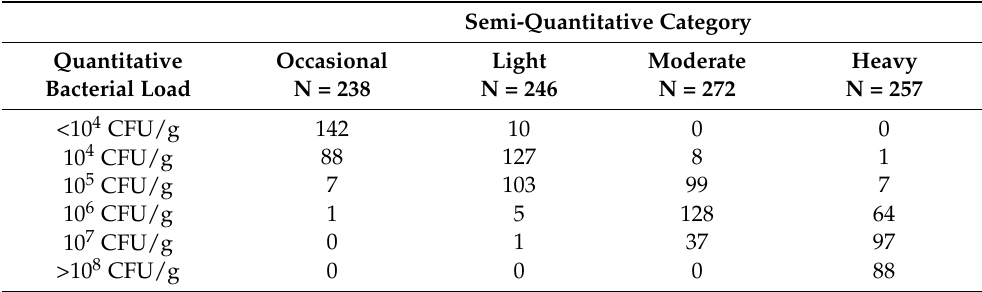
Table 2. Distribution of bacterial loads per semi-quantitative culture category. Values represent the number of isolates within each semi-quantitative category with the corresponding bacterial load reported by quantitative culture. N represents the total number of isolates per semi-quantitative category. 40 isolates yielded ‘no growth’ and bacterial loads of 0